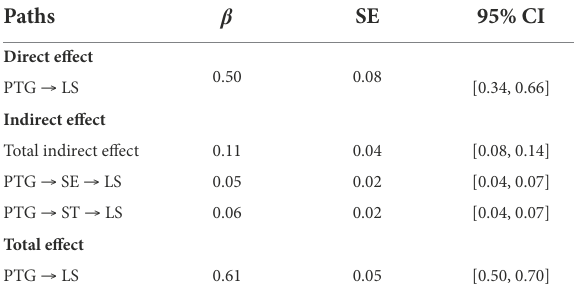
TABLE 3 Testing the mediation effects of SE and ST values between PTG and LS.